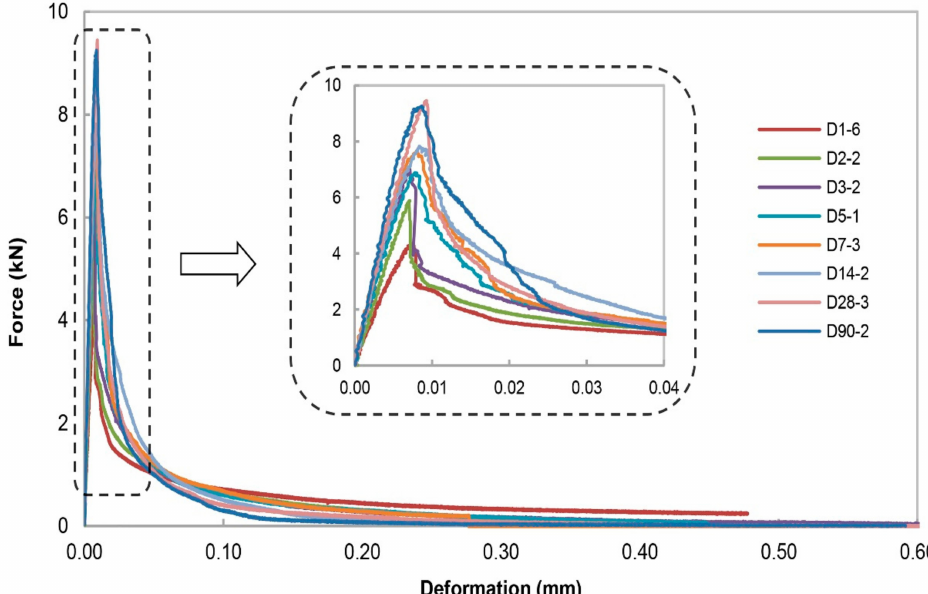
Figure 8. Overview of the force-deformation curves for specimen type 16 that were fractured at the center of the specimen as function of testing age. ‘D1’ represents the specimen type 16 tested at an age of 1 day after casting; ‘-6’ represents the order number of the specimen for each specific